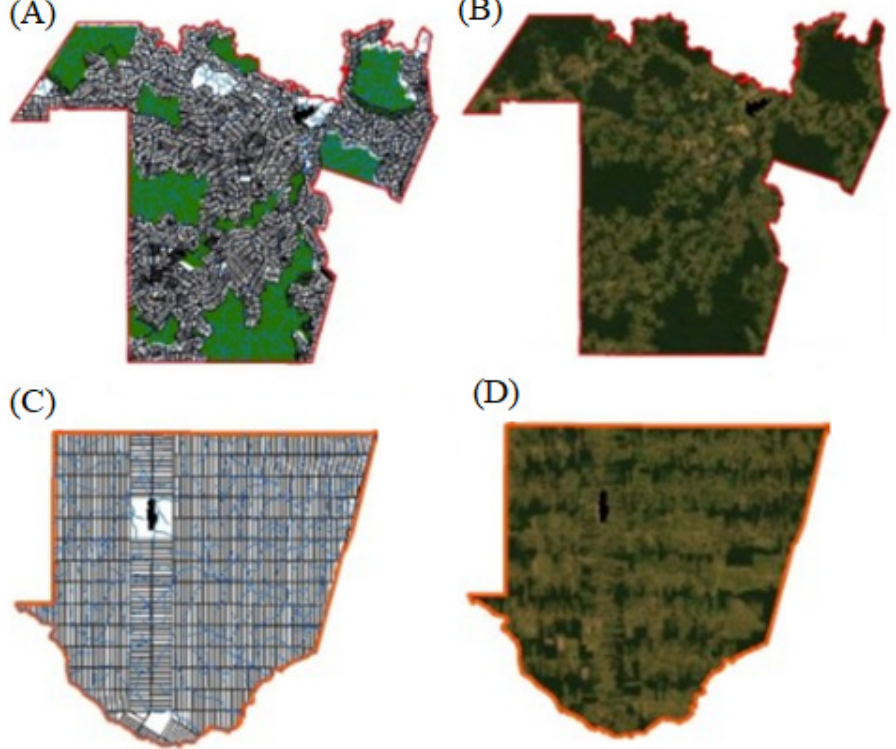
Figure 6. Different models of occupation called topographic or disorganised multidirectional ( A , B ) and fishbone ( C , D ) implemented in Machadinho ( A , B ) and Anari ( C , D ) settlements. Table 4. Transition matrix for the fishbone (Anari settlement) and topographic or disorganized multidirectional (Machadinho settlement) models from 1984 to